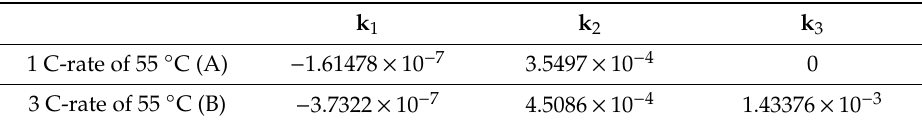
Table 5. The k-values of 1 and 3 C-rate, respectively, at 55 ◦ C. k 1 k